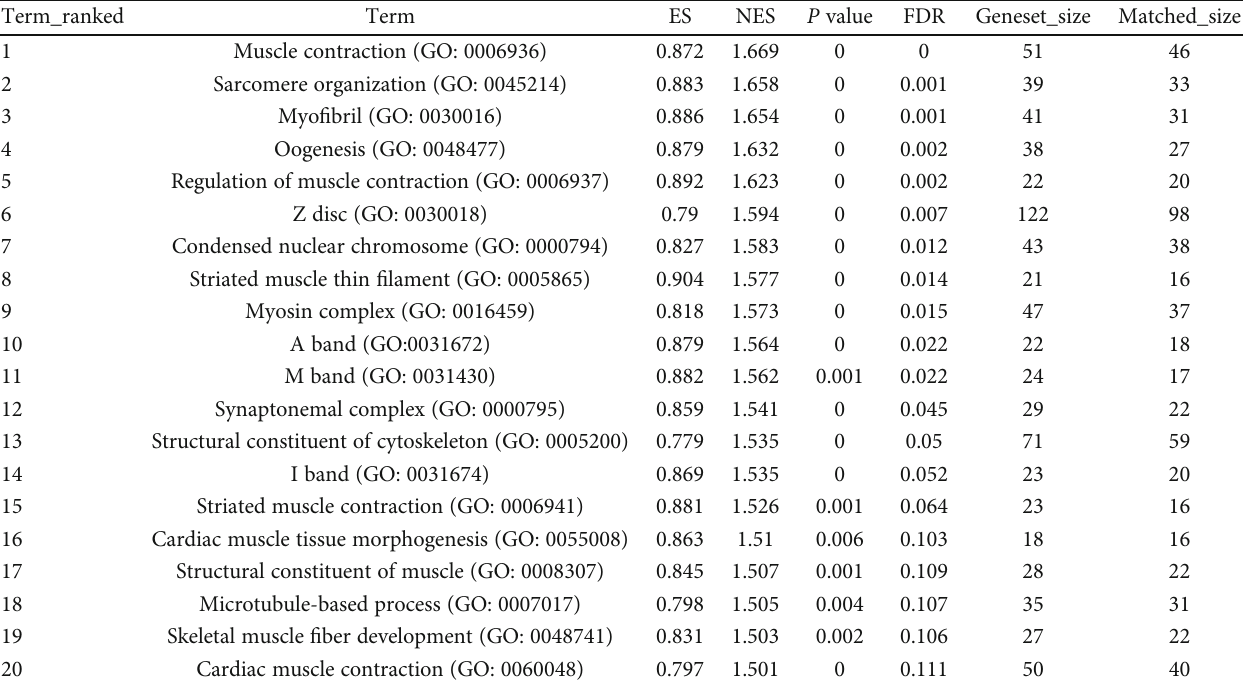
Table 3: The signi fi cant enriched GO pathways from GSEA results ( ∗∗ P < 0 : 01 , FDR < 0 : 25